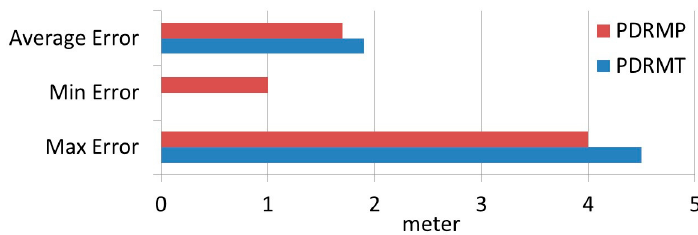
Figure 24. Distance error based PDRM with and without considering PPE.